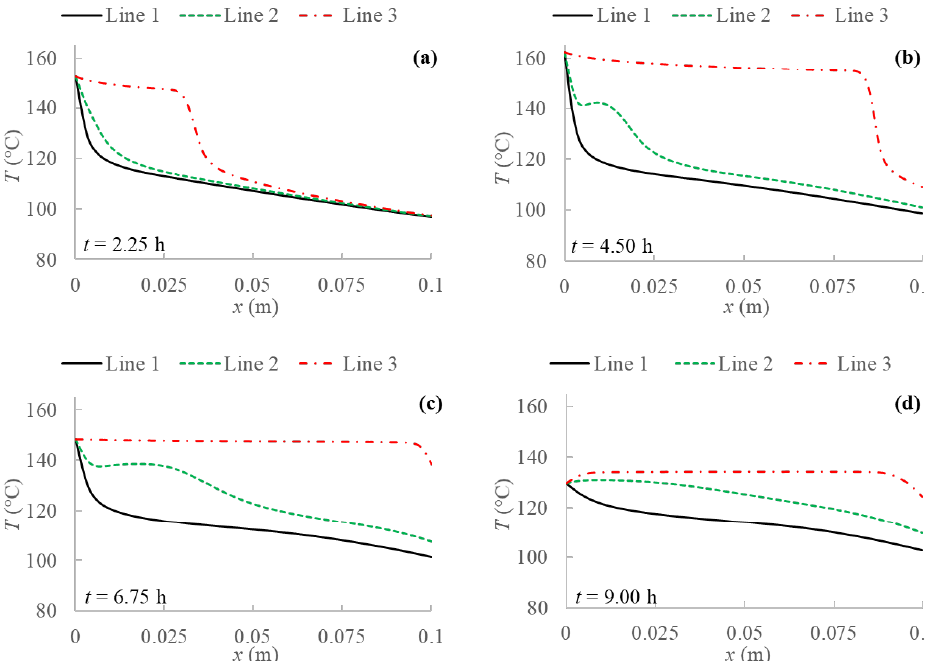
Figure 8. Temperature profiles for 2D model with natural convection and BC 4 evaluated at three different PCM transversal sections: Line 1 ( y = 0 m); Line 2 ( y = 0.05 m); Line 3 ( y = 0.1 m), and at different evaluation times: ( a ) after 2.25 h; ( b ) after 4.50 h; ( c ) after 6.75 h; ( d ) after 9.00 h from the simulation beginning respectively.